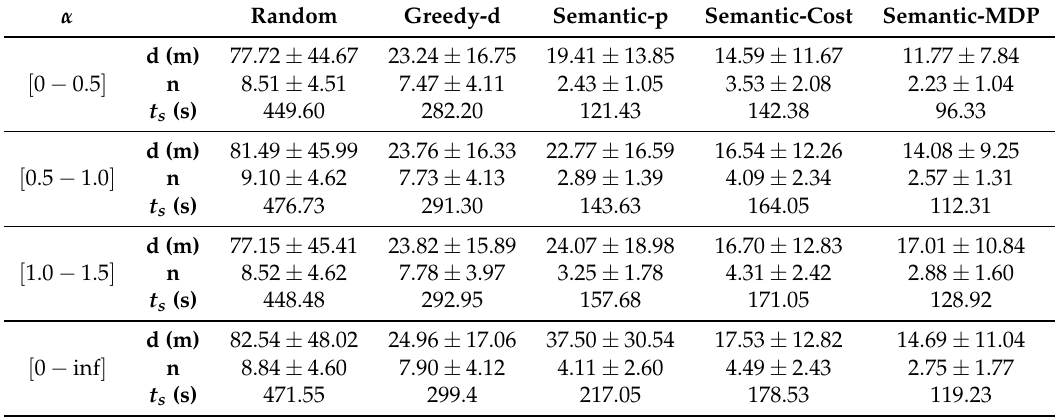
Table 1. Travelled distance ( d ), number of inspected objects ( n ) and average search time ( t s ) for different search strategies and gas classification ambiguities ( α